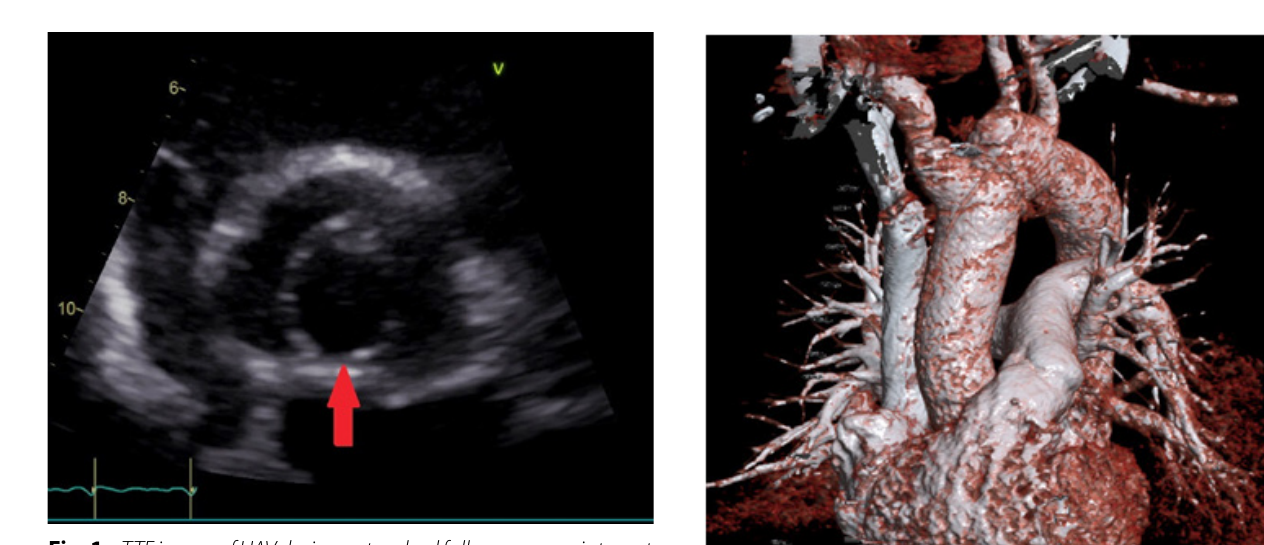
Fig. 1 – TTE image of UAV during a standard follow-up appointment. The red arrow indicates the aortic commissure.